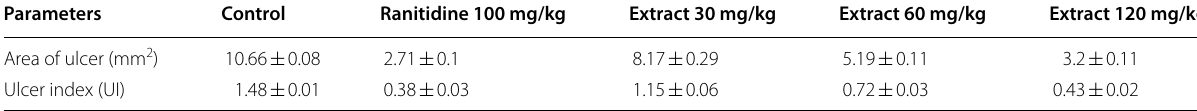
Table 2 Effect of C. zeylanica extract on area of ulcer and ulcer index in histamine-induced acute ulcers Parameters